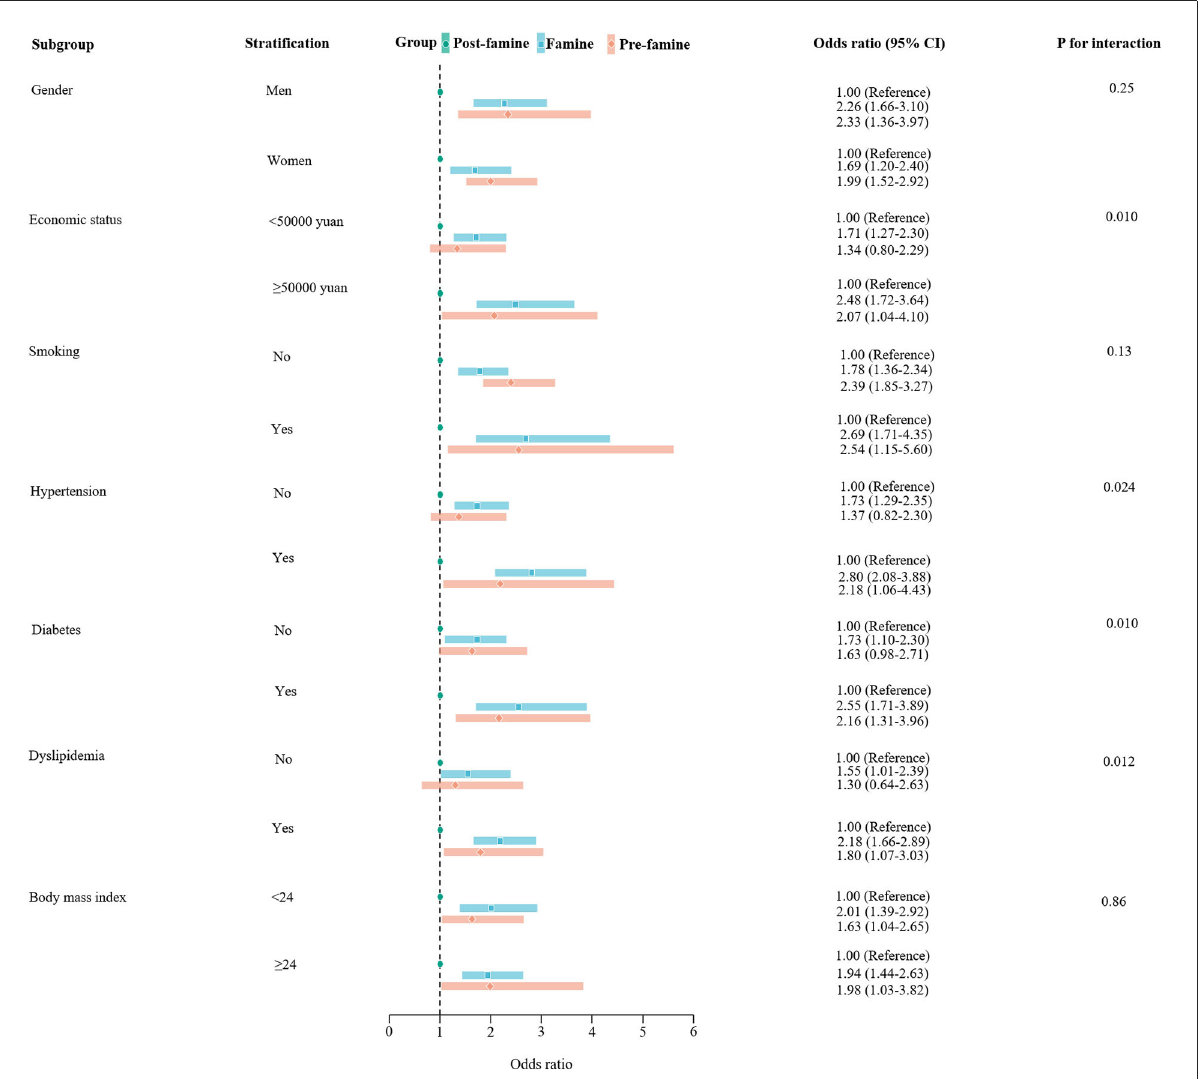
FIGURE2 Stratification analysis of associations of pre-famine and famine births with risk of hospitalization for heart failure compared with post-famine births. Presented were multivariable-adjusted generalized linear models with adjustment for age, sex, marriage, educational status,